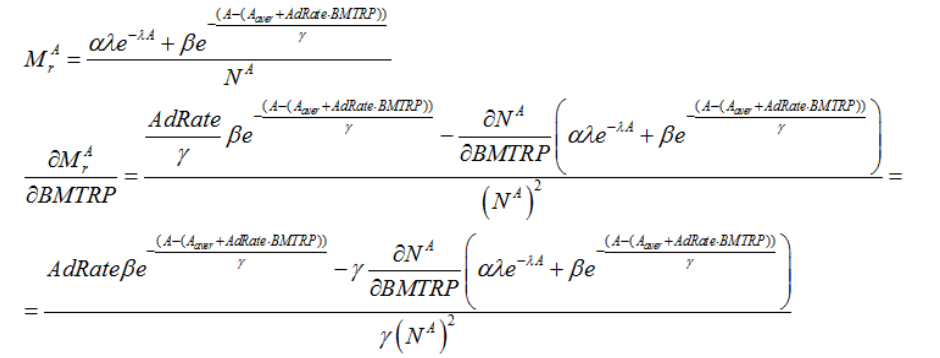
Figure 5. Mortality and rejuvenation rates. Mortality rate at age A is the percentage